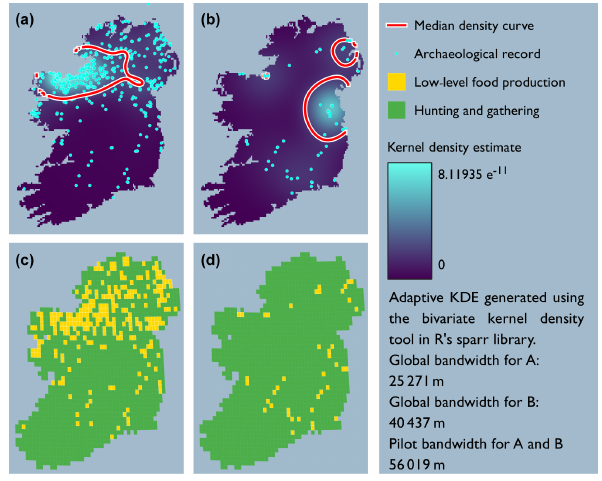
Figure 5. An example of regional land use mapping. (a, b) The distribution of known archaeological sites superimposed on ker- nel density estimates of the extent of land use based on the den- sity of observations and (c, d) these data superimposed on the LandCover6k land use classes for the middle Neolithic (3600– 3400 years BCE, 5600–5400 years BP, 5.6–5.4kaBP) (a, c) and the early Neolithic (3750–3600 years BCE, 5750–5600 years BP, 5.7–5.6kaBP) (b, d) in Ireland. Data points derive from 14 C-dated archaeological sites and distributions of settlements and monuments that have been assigned to each archaeological period following the dataset published in McLaughlin et al. (2016). The assigned land use classes are inferred from archaeological material from one site (or multiple sites) within the grid box. It should not be assumed that the whole grid cell was being used for agriculture during the mid- dle and early Neolithic. Informed assessment suggests that agricul- tural land (crop growing and grazing combined) probably occupied 10%–15% of the total grid area in the low-level food production regions of the eastern and western coastal areas, whilst agricultural land likely represents 5% or less of the total grid cell area in inland